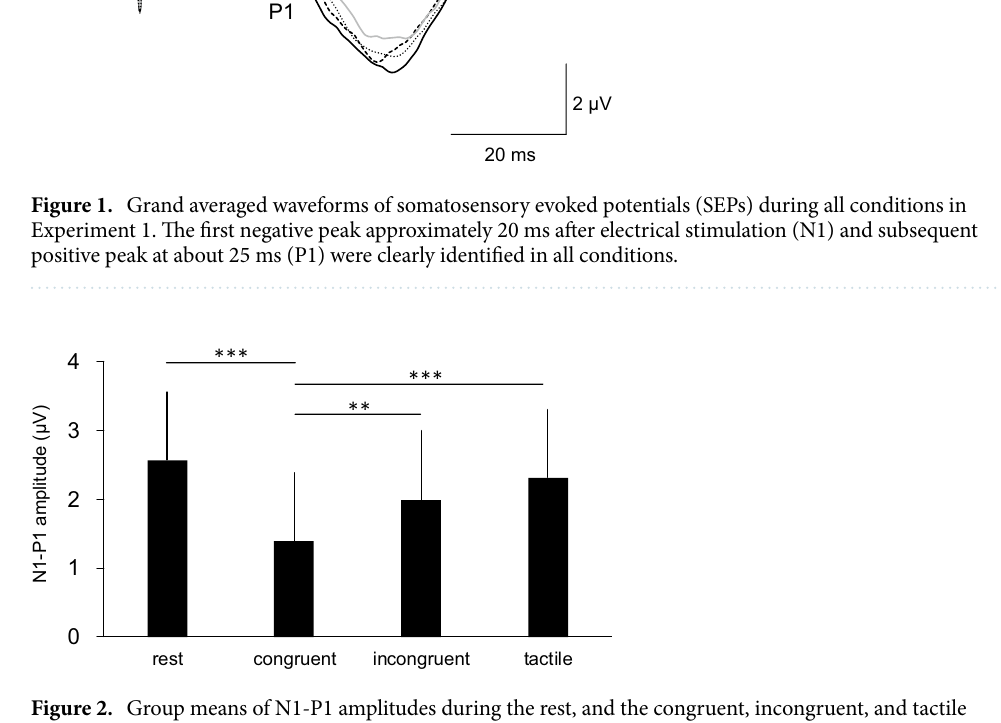
Figure 2. Group means of N1-P1 amplitudes during the rest, and the congruent, incongruent, and tactile stroking conditions in experiment 1. Data are represented as mean ± one SD. ** p < 0.01, *** p <